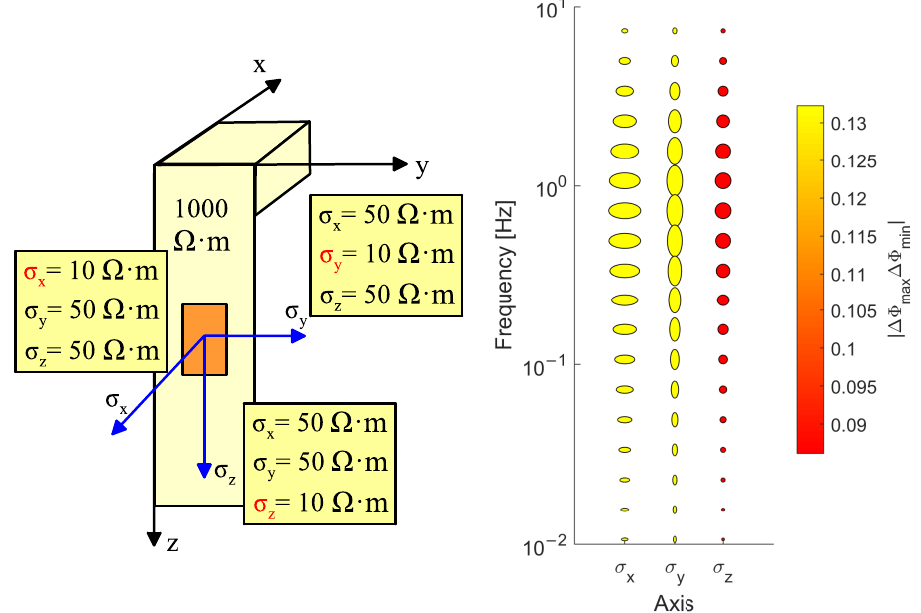
Figure 6. Fracture isotropic model and residual phase tensor results.